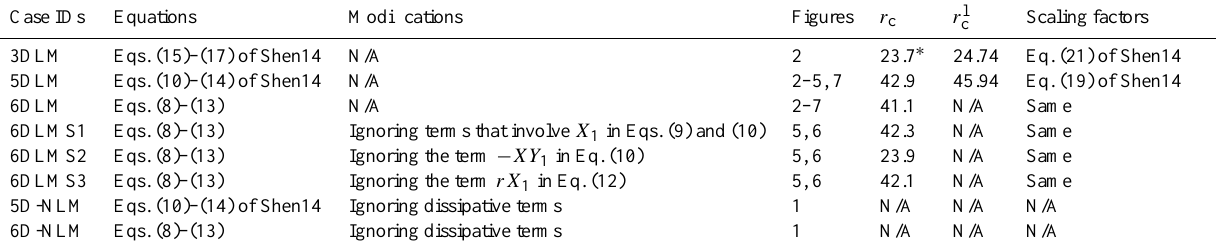
Table 1. A list of numerical experiments for different Lorenz models. The column “Modifications” indicates additional changes in the “Equations”. The r c and r l c are determined based on the eLE analyses and the linear stability analysis, respectively. Solutions in “Figures” are rescaled using the factors listed in the “Scaling factors”. ∗ For the 3DLM, the ensemble averaged LE is 1 . 2 × 10 − 2 at r = 23 . 7, and becomes 0.26 at r = 24. The 5-D and 6-D non-dissipative Lorenz models (5D-NLM and 6D-NLM) are used to examine the energy conservation